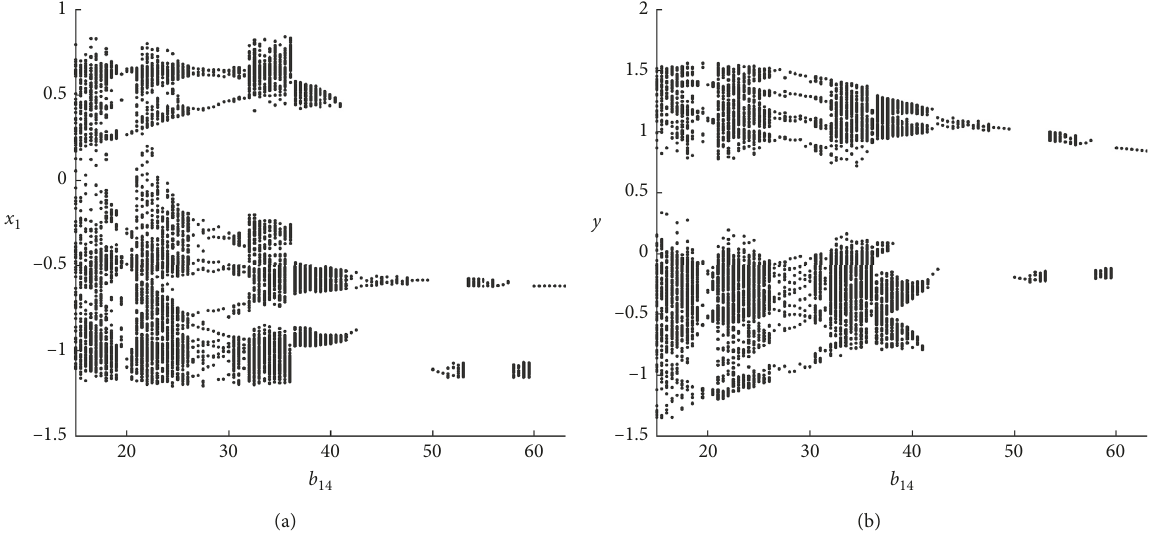
Figure 9: Bifurcation diagrams of the (a) horizontal mode and (b) vertical mode via the change of the parameter b